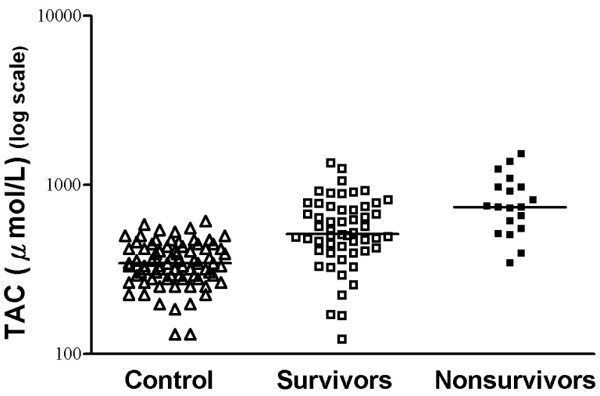
Serum TAC in control and patients (stratified by outcome). The trial included a total of 76 healthy control individuals; of the 73 patients, 54 survived ('survivors') and 19 died ('nonsurvivors'). The horizontal bars represent the mean level for each group. TAC, total antioxidant capacity.